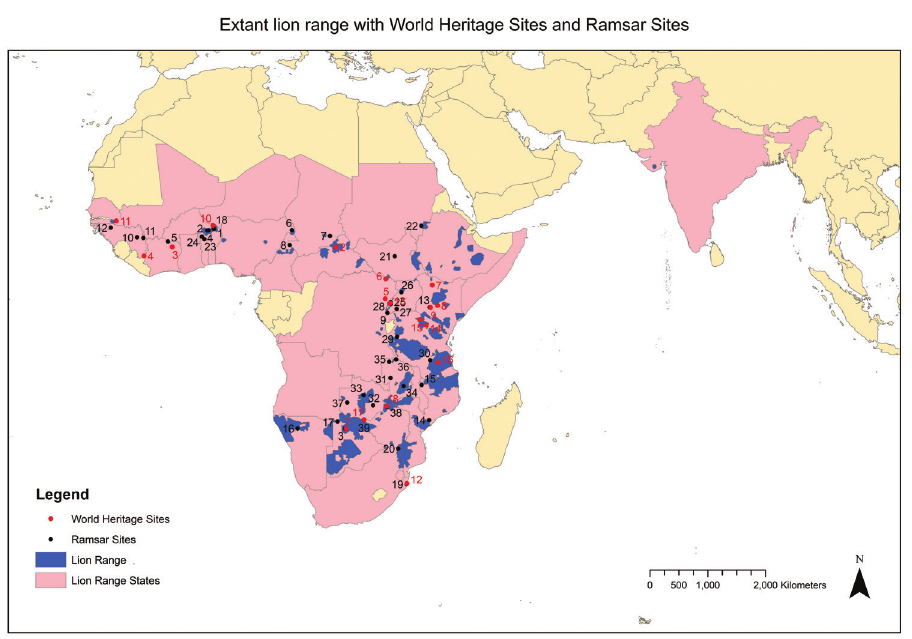
Figure 1. Extant lion range (excluding small fenced reserves), Ramsar-listed sites and World Heritage sites. The numbers indicate the locations of the sites listed in Tables 3 and